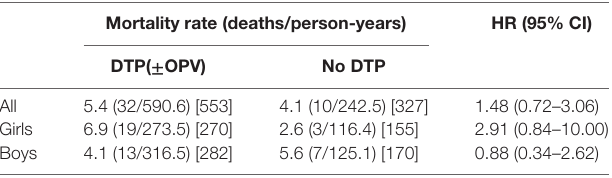
TaBle 3 | Analysis 2: mortality rates (MR) per 100 person-years and hazard ratios (HR) of 6–35 months old DTP-vaccinated and diphtheria–tetanus–pertussis (DTP)-unvaccinated